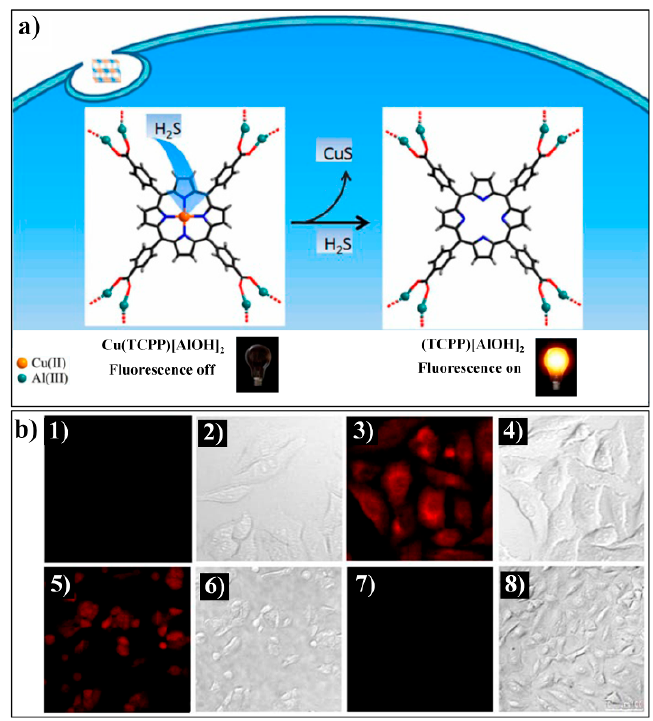
Figure 5. ( a ) The proposed strategy for the fluorescent variation of Cu(TCPP)[AlOH] 2 for H 2 S. ( b ) Confocal fluorescence images in living cells: (1) image of HepG2 cells incubated with 10 μ M Cu(TCPP)[AlOH] 2 ; (2) bright-field image of (1); (3) image of HepG2 cells incubated with 10 μ M Cu(TCPP)[AlOH] 2 and 50 μ M NaHS; (4) bright-field image of (3); (5) image of A549 cells incubated with 500 μ M SNP and 10 μ M Cu(TCPP)[AlOH] 2 ; (6) bright-field image of (5); (7) image of A549 cells incubated with 250 mg·L − 1 DL -propargylglycine (PPG) and 10 μ M Cu(TCPP)[AlOH] 2 ; (8) bright-field image of (7). Reproduced with permission from [81]. Copyright American Chemical Society, 2014.